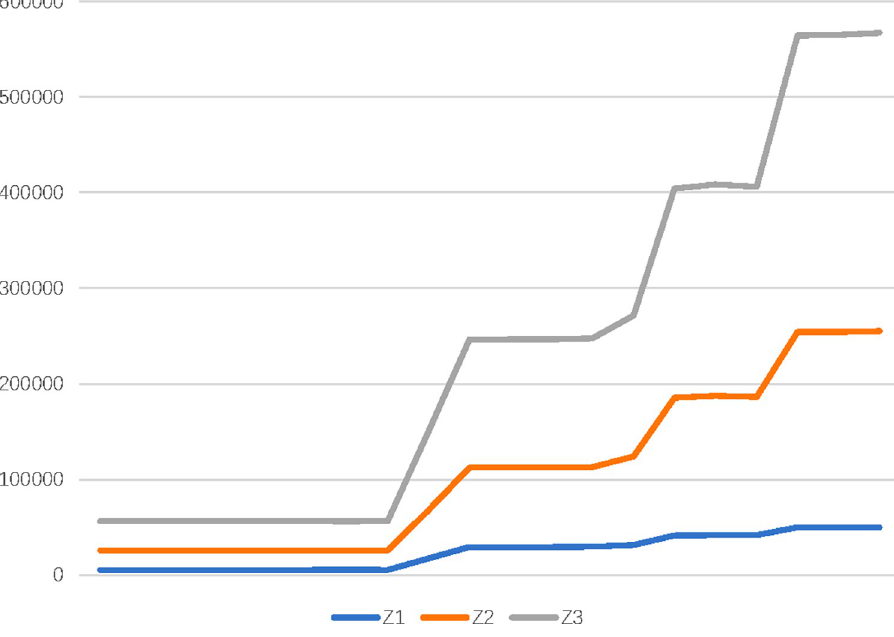
Fig 4. reto front with twenty weights for α = 0.1 of LP-Metrics method.